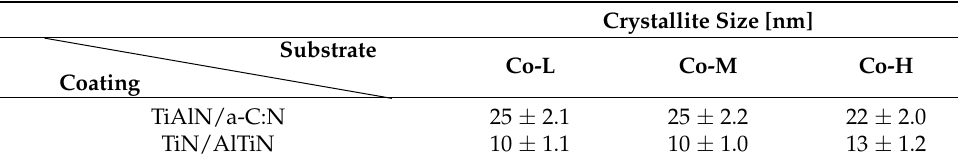
Table 2. Crystallite size of the Ti(Al)N phase for both coatings 5 µm thick.